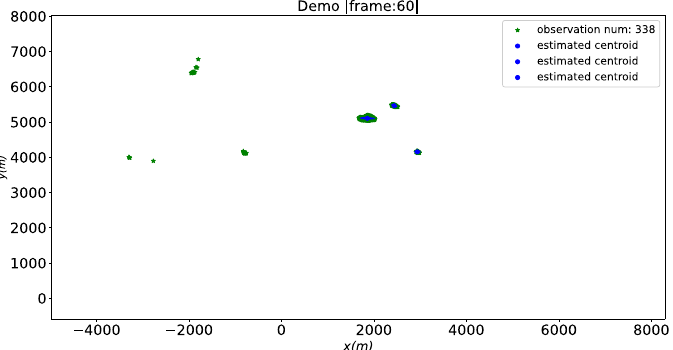
Figure 22. Multi-target in the Cartesian coordinate system tracking in the 60th frame.